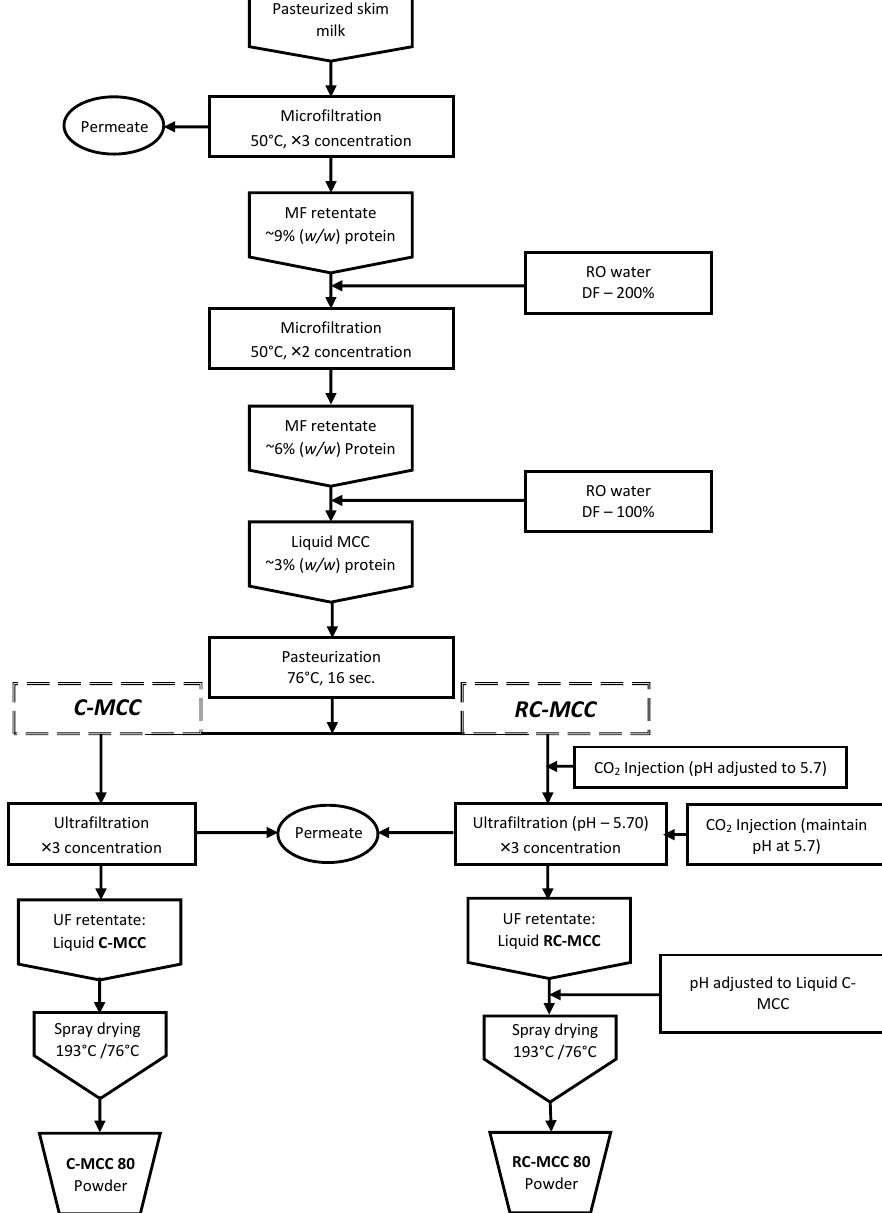
Figure 1. Schematic of the production of MCC 80 powders with and without calcium reduction.